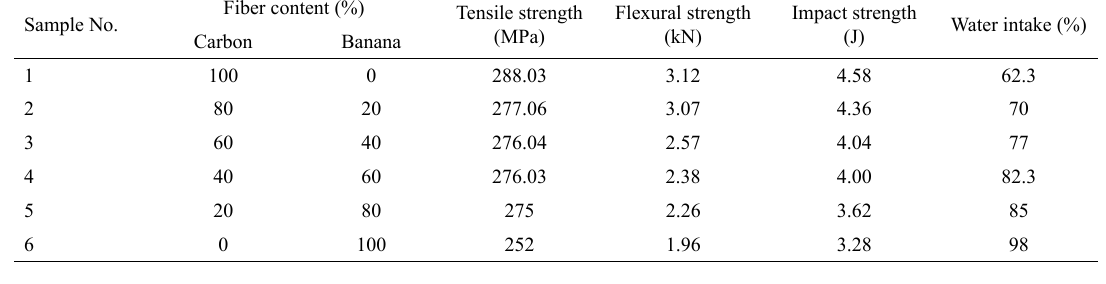
Table 2: Experimental results of the banana/carbon fiber composites Sample No.